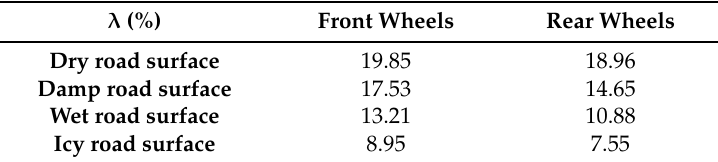
Table 2. Optimal wheel slip values for several road conditions.